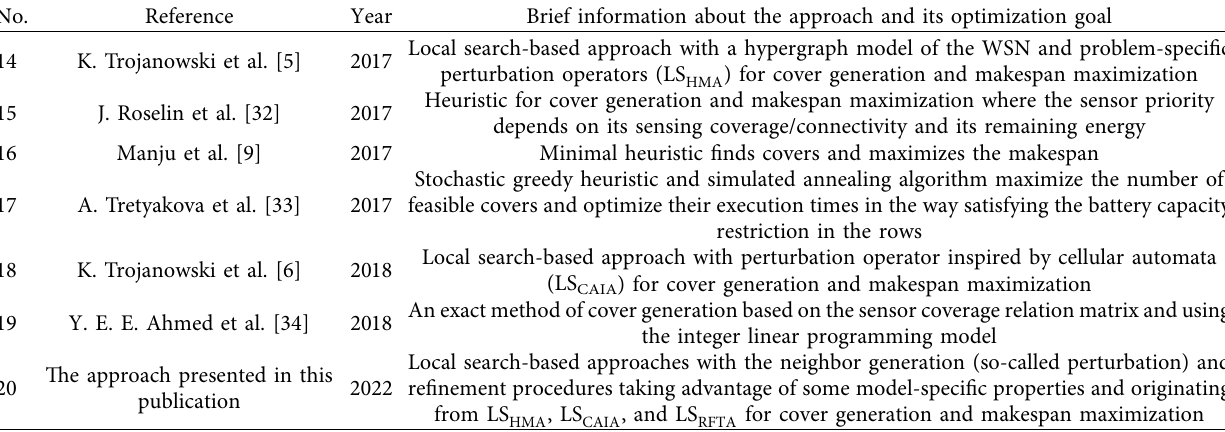
Table 3: Selected papers on MLCP optimization with Non-Disjoint Set Cover based approaches—Part II.